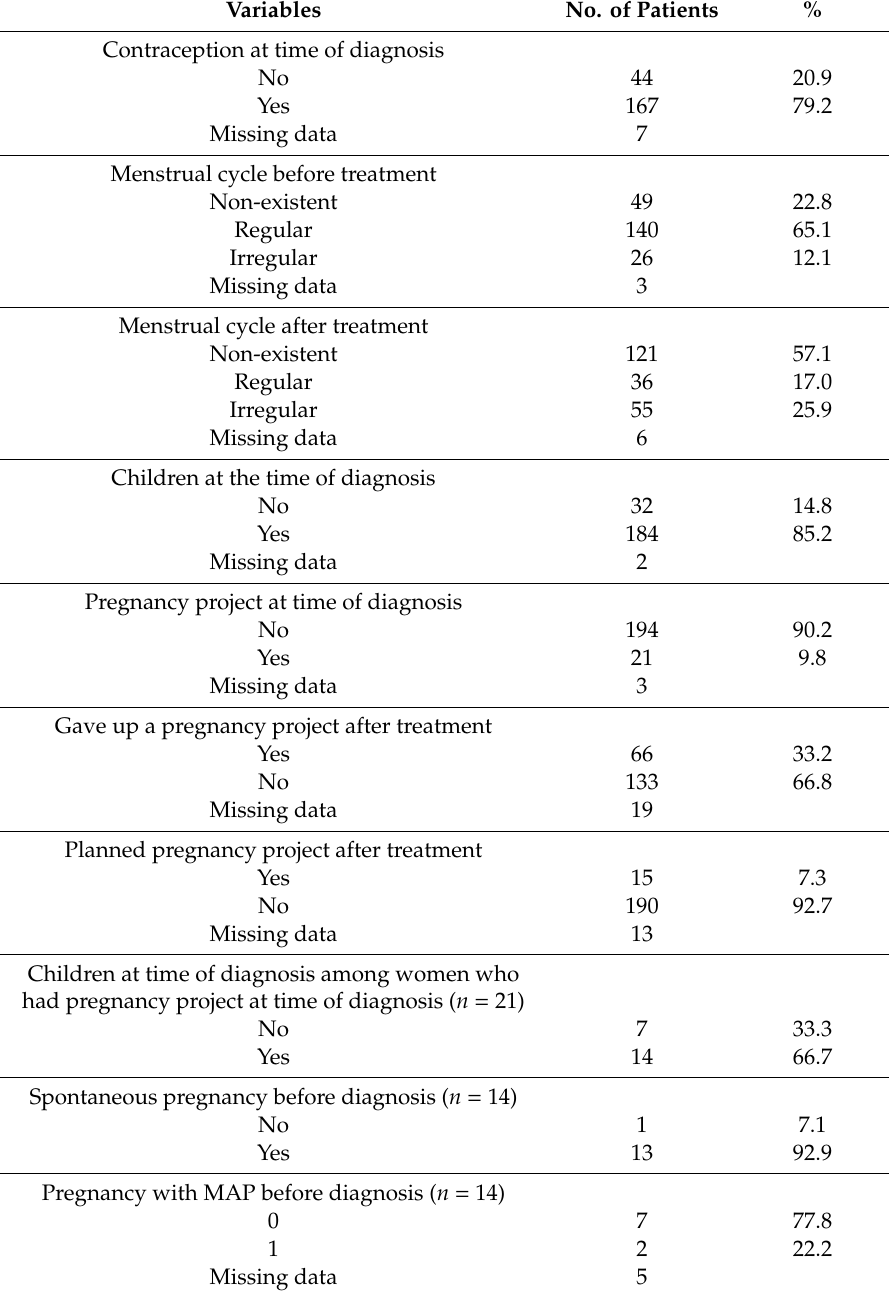
Table 4. Fertility data of the study